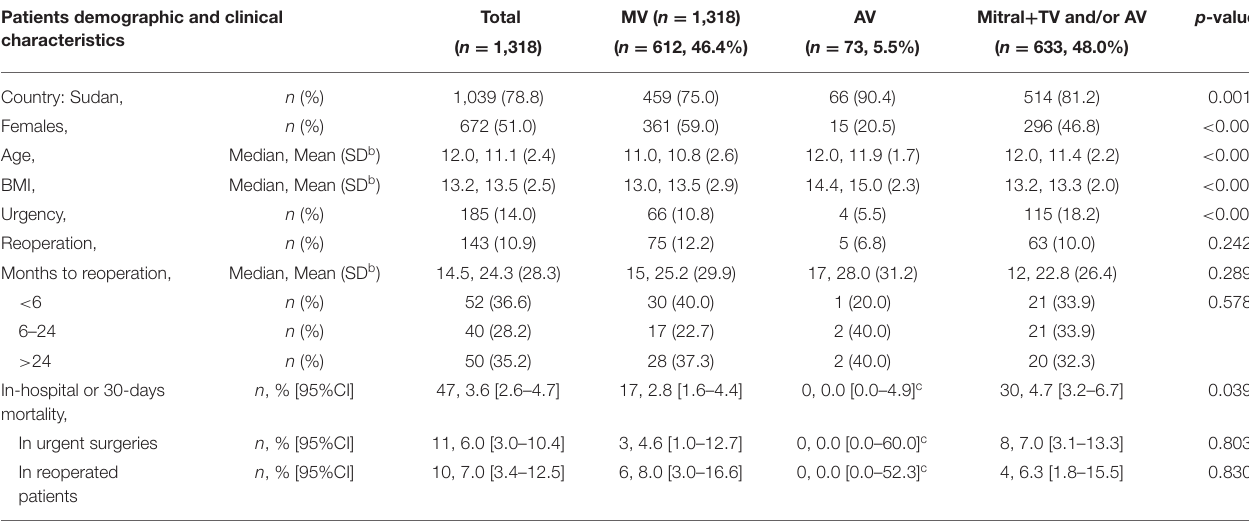
TABLE 1 | Main characteristics and clinical outcomes of the overall sample of 1,318 RHD children and stratified according to valve surgery subgroups: isolated mitral valve (MV), isolated aortic valve (AV), and mitral and tricuspid and/or aortic valves (MV + TV and/or AV). Patients demographic and clinical characteristics